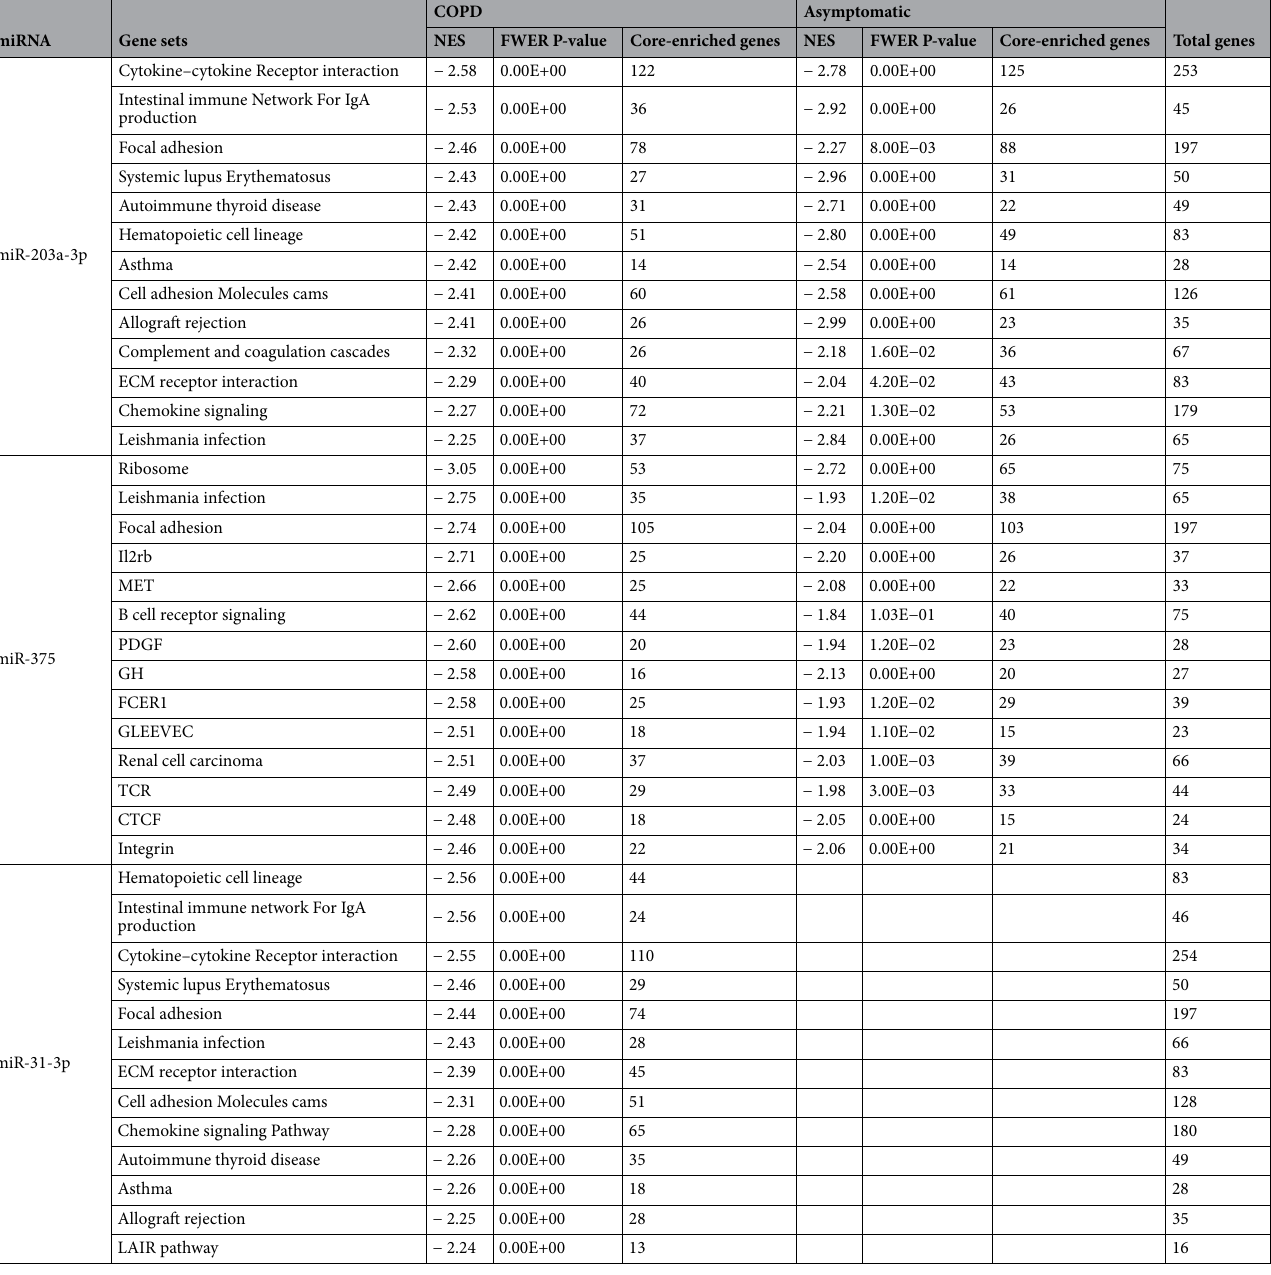
Table 4. Significant gene sets negatively affected by the identified miRNAs in COPD patients and asymptomatic participants. Only the top pathways with a family-wise error rate < 0.05 in the COPD patients are shown. NES normalized enrichment score, FWER P-value family-wise error rate